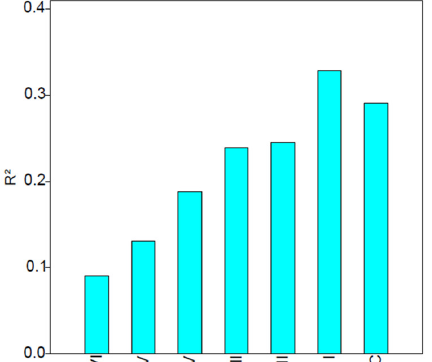
Figure 3. Evolution of the coefficient of determination between WQI and SPI as the water and diatom sampling dates approach, from water samples taken 6 months before diatoms (VI) to the nearest sampling date (C). Table 2. Evolution of p values over time from C (date closest to the date of diatom sampling) to VI (6 months before this